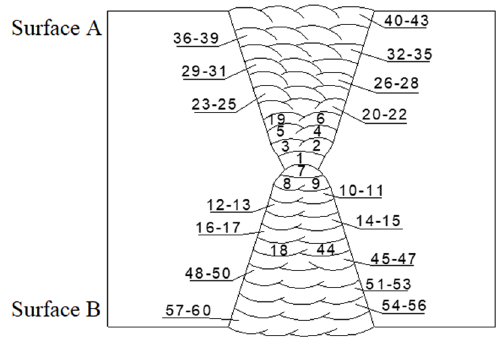
Figure 4. Weld bead layout.